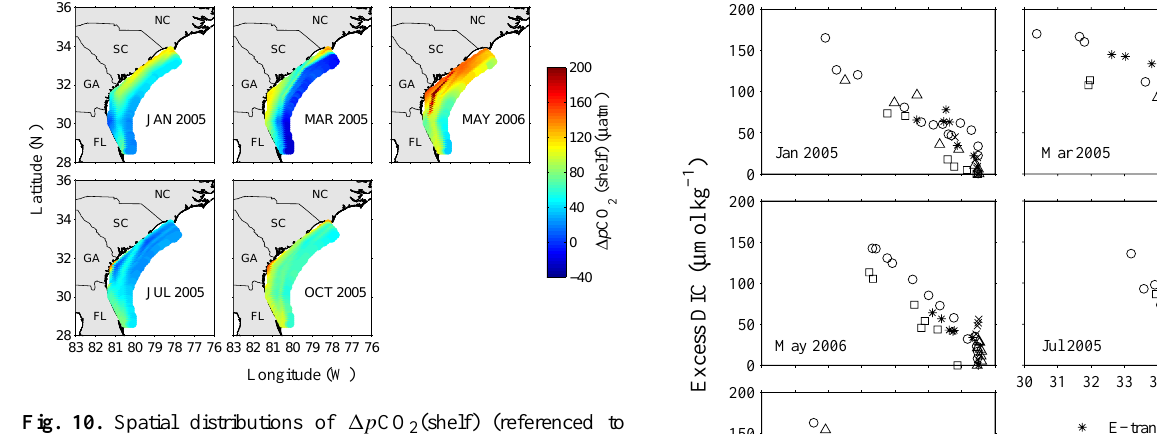
Fig. 10. Spatial distributions of 1p CO 2 (shelf) (referenced to 23.11 ◦ C). Due to a lack of DIC data, 1p CO 2 (shelf) in December 2005 is not presented. The colored contours are from triangle-based liner interpolation.